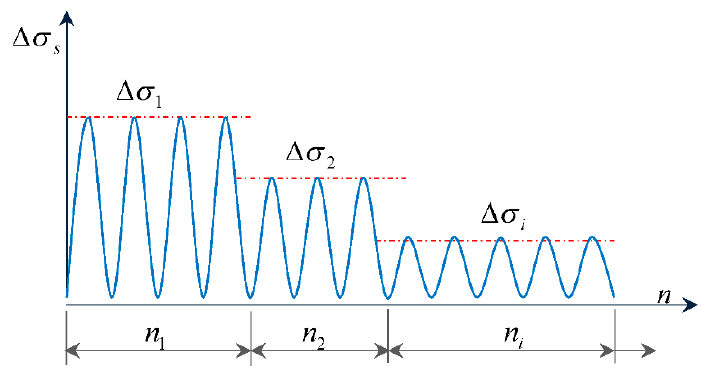
Figure 3. Examples of load spectrum under bending amplitude variation. Table 1. Load spectrum of steel bridge deck asphalt pavement structure. Level i